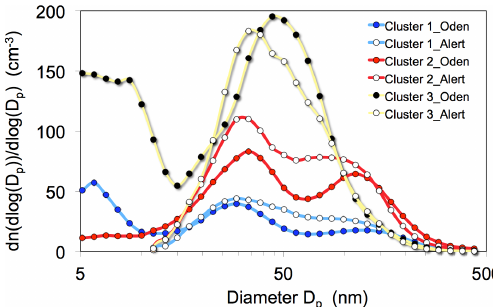
Figure 13. Average number size distributions in three clusters of harmonized particle size distributions measured on Oden during all cruises and at Alert, Nunavut during the Augusts of 2011, 2012, and 2013. There are no Alert data below 11nm